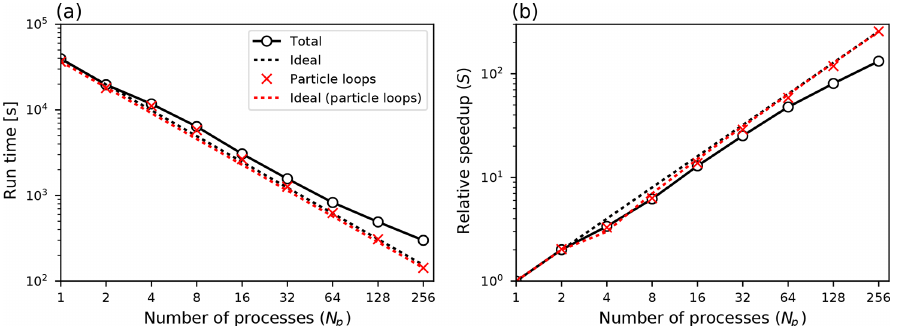
Figure 8. Computational time (a) and speedup (b) for up to 256 processes on 16 nodes. Logarithmic scaling along both axes. For n ≥ 4 a dedicated process reads and distributes input